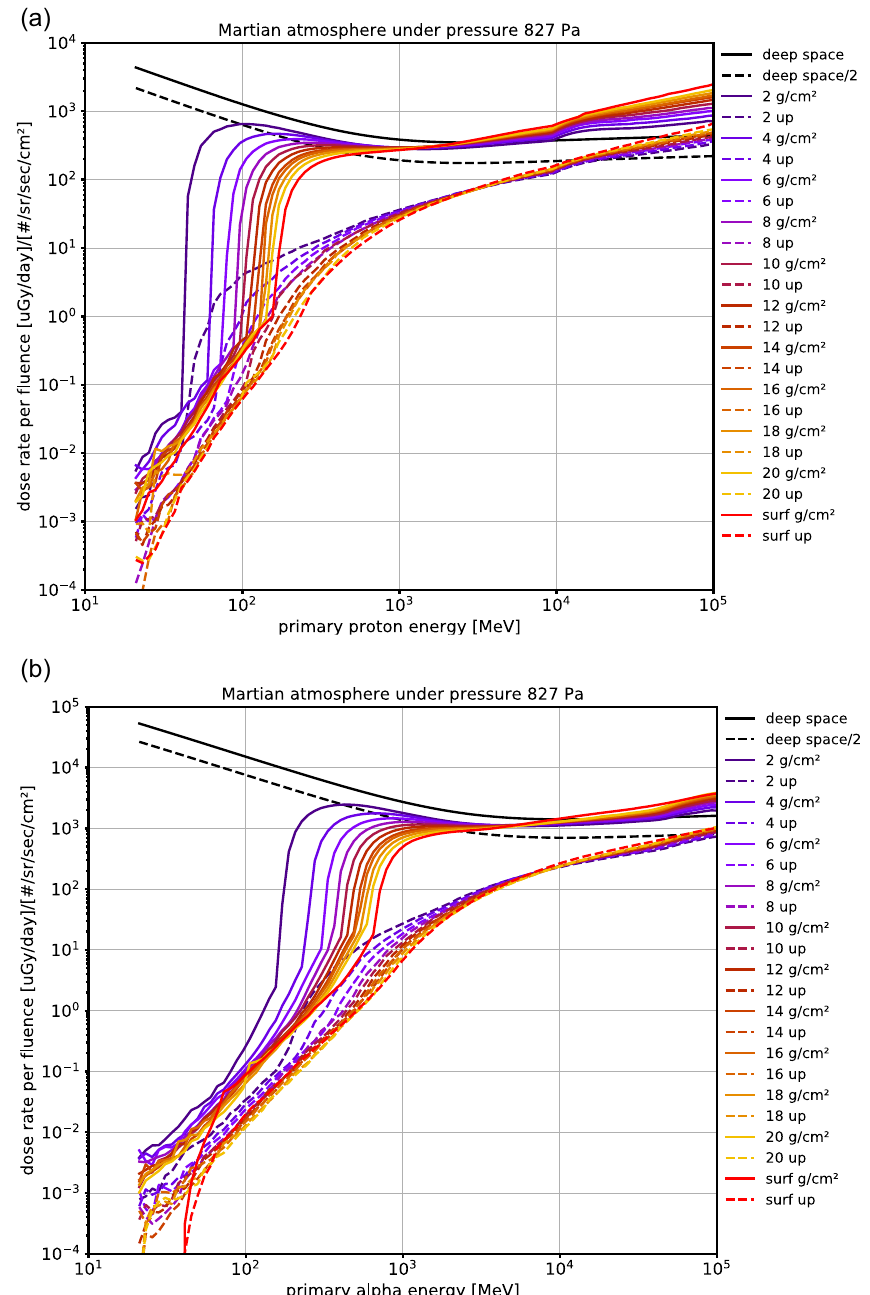
Fig. 3. Dose rate in water per primary fl ux function for protons (a) and 4 He ions (b) at different depth (2,4,6 ... 20 and surface) of the Martian atmosphere. The total vertical atmospheric depth under a surface pressure of 827 Pa is about 23 g/cm 2 . Solid lines are for the total dose rate while dashed lines represent the upward contribution. Black lines mark the deep space case similar to Figure